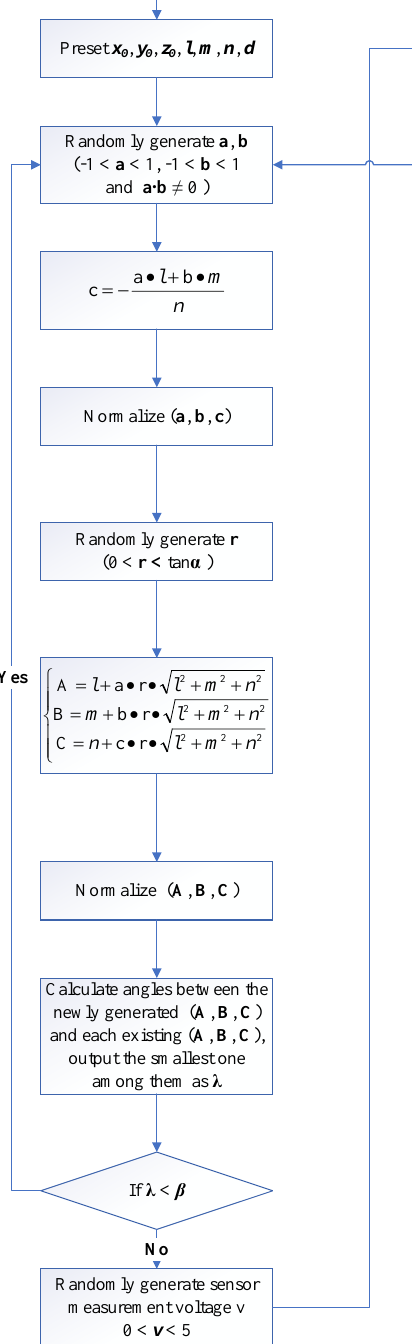
Figure 4. Whole procedure of the simulation